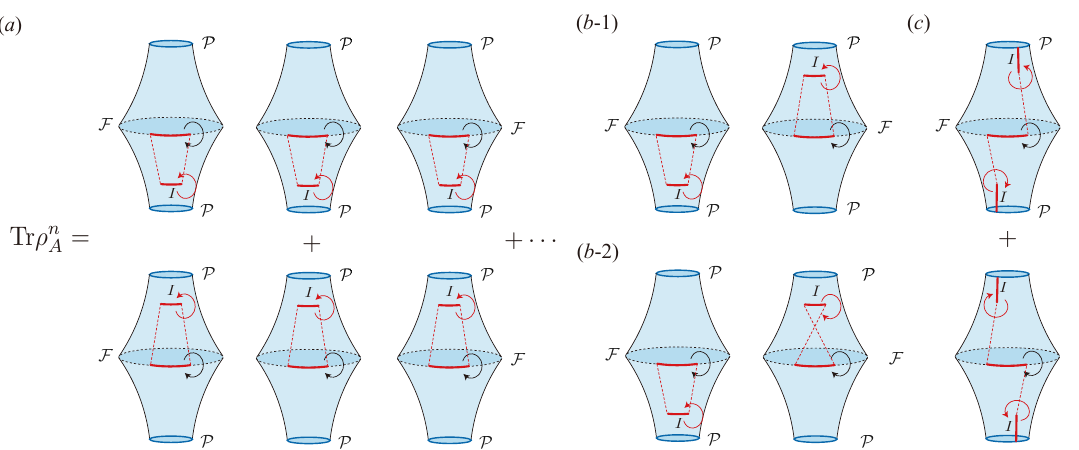
Figure 8 . ( a ) The leading contribution to Tr ρ n from the replica wormholes. This contribution A consists of two geometries, one has island in the ket part and the other in the bra part. ( b ) The replica wormholes that connect the bra and the ket part of the geometry. ( c ) The initial time slice is now replicated, and the emergent twist operators appear at both the bra and the ket part of the geometry. The entropy from this configuration is S A = 2 S B + S Island , therefore this saddle is always A subdominant, as long as S B > 0